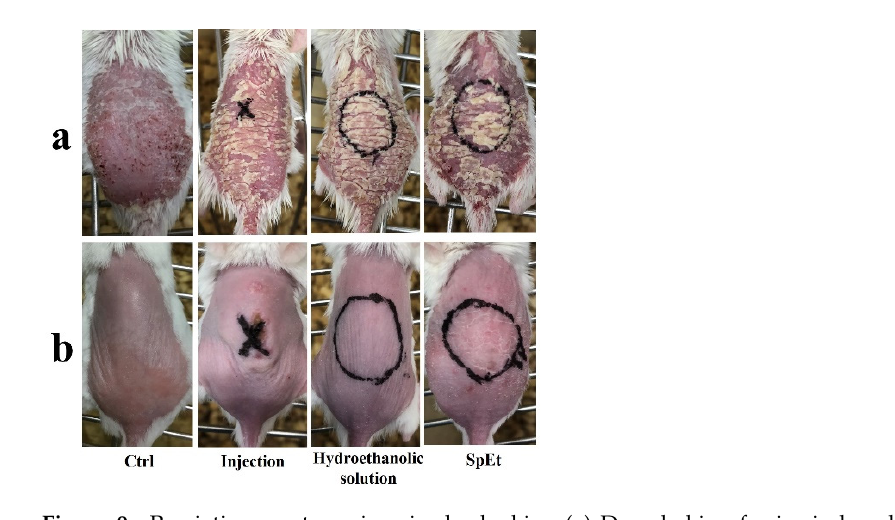
Figure 9. Psoriatic symptoms in mice back skin. ( a ) Dorsal skin of mice induced by IMQ for 7 consecutive days. ( b ) Dorsal skin of mice after different treatments.